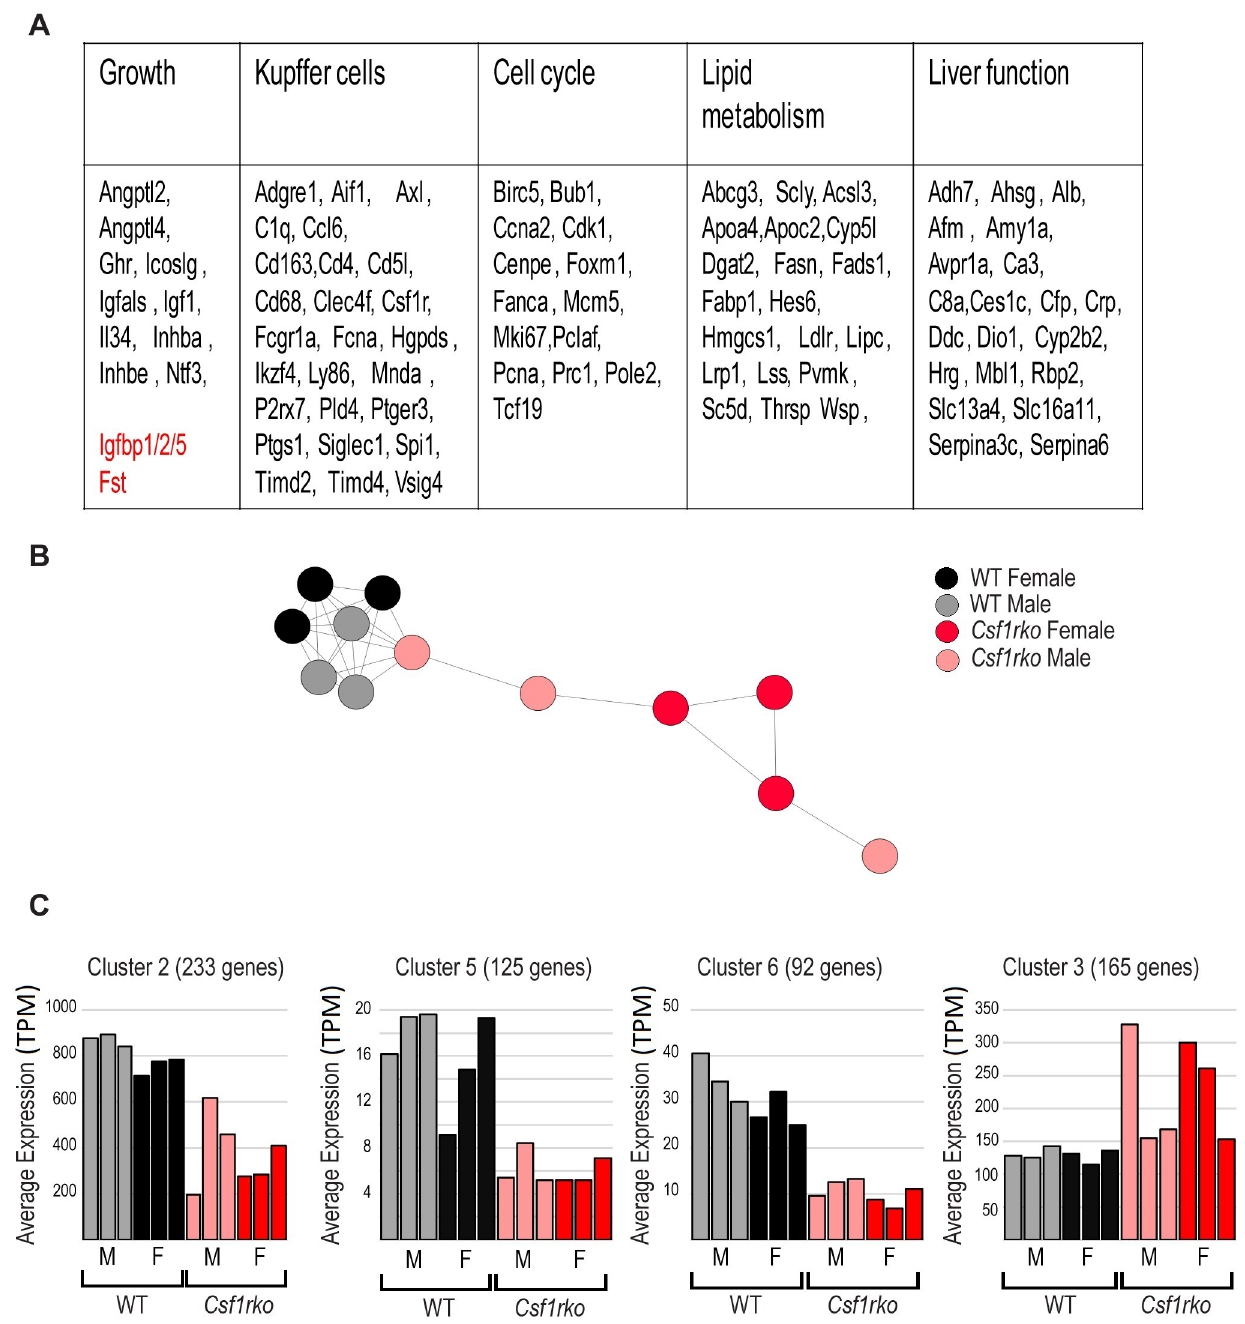
Fig 4. Analysis of gene expression in livers of WT and Csf1rko rats. RNA-seq analysis was performed on liver RNA from 3 male and 3 female WT and Csf1rko rats at 3 wks of age. The full data set and the differentially-expressed gene analysis are provided in S1A and S1B Table. Co-expression cluster analysis was performed using BioLayout as described in Materials and Methods. (A) Summary of regulated genes. Genes shown were regulated > 2 fold in the livers of Csf1rko rats compared to WT. They have been assigned to categories based upon known function or expression. Genes in red encode proteins that inhibit liver or somatic growth and are over-expressed in the Csf1rko . (B) Sample to sample analysis of Csf1rko and WT liver samples. Circles represent samples and lines between them show correlations of r � 0.93 between expression patterns of pairs of samples across all genes. (C) Average expression profile of four clusters of co-expressed transcripts generated using a gene to gene analysis in BioLayout that distinguish Csf1rko and WT liver. Full list of transcripts within each cluster is provided in S1C Table and GO annotation in S1D Table. Y axis shows the average expression of transcripts in the cluster (TPM); X axis shows the samples with columns colored as for (B).